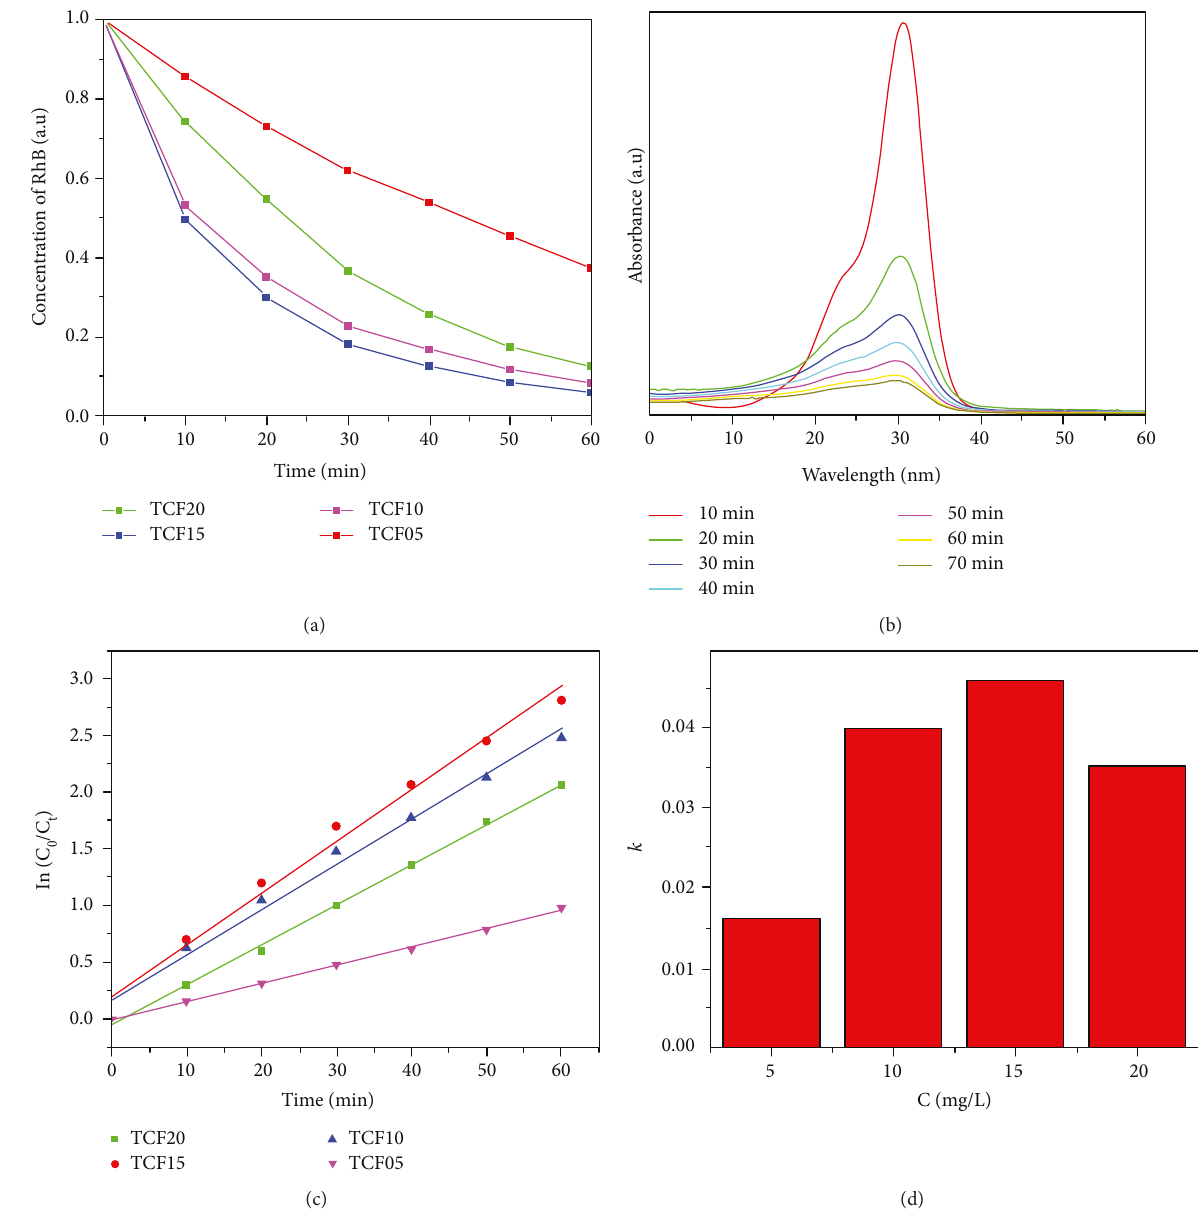
Figure 4: (a) The photocatalytic degradation of RhB with di ff erent TiO /carbon fi ber micronanocomposites under UV light irradiation. (b) 2 Absorption spectral changes of RhB solution under UV light irradiation in the presence of TCF15. (c) The degradation kinetic data of RhB under UV light irradiation at di ff erent sampling time (d). Degradation rate K value of di ff erent